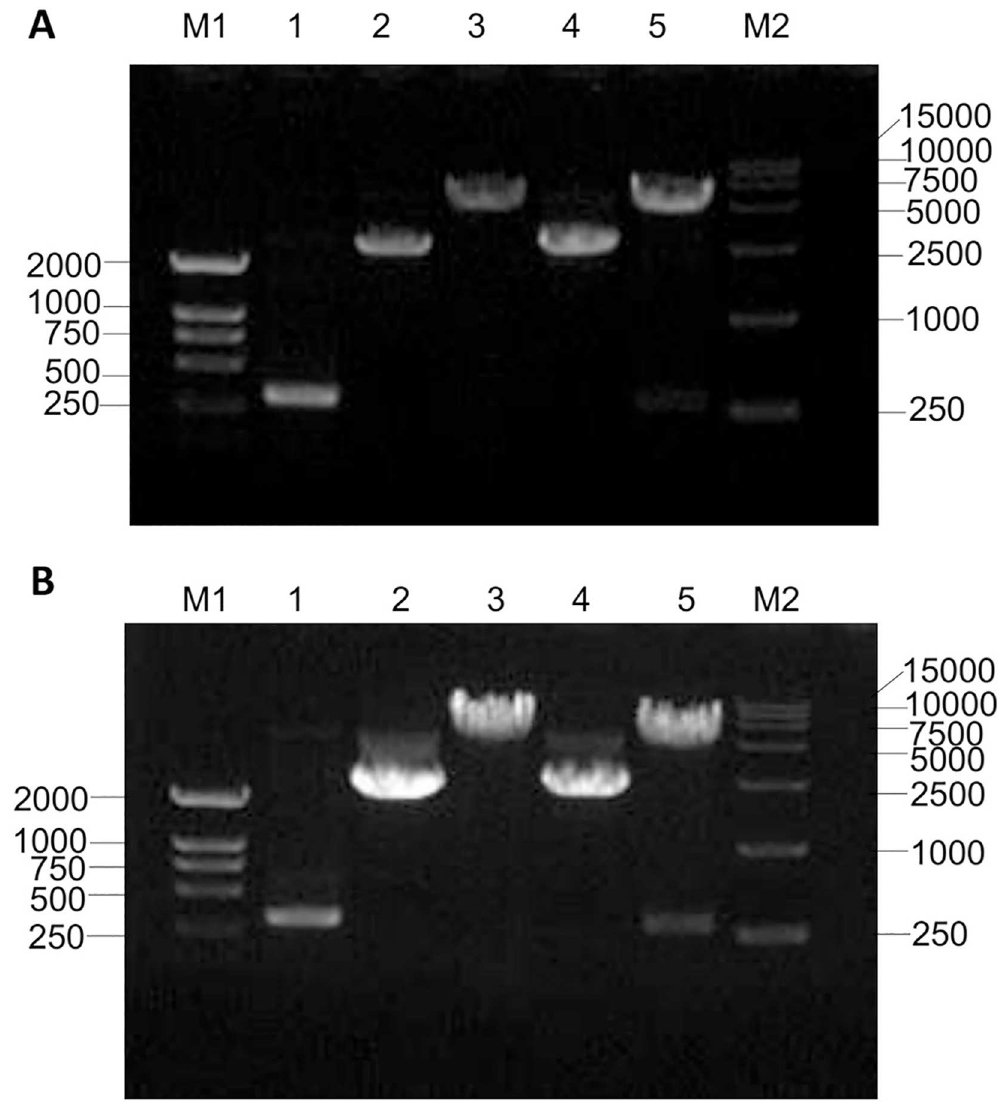
Fig 1. Construction of the expression vector of the HPV58 E7. (A) Constructionof pGEX-4T2-(HPV58-E7) vector. The lane M1 shows the TaKaRa DL2000DNA marker, lane 1 shows the HPV58 E7 gene (PCR from human HPV58-positive cervical epithelialcells); lane 2 is the pGEX-4T2 vector; lane 3 is the cleavedpGEX-4T2 vector by Eco R I and Bam H I; lane 4 shows the reconstructed pGEX-4T2-(HPV58-E7) vector; lane 5 is the verification of pGEX-4T2-(HPV58-E7) vector which was cleavedby Eco R I and Bam H I; the lane M2 is TaKaRa DL 15,000DNA marker. (B) Construction of pEGFP-C1-(HPV58-E7) vector. The lane M1 shows the TaKaRa DL2000DNA marker, lane 1 shows the HPV58 E7 gene (PCR from pGEX-4T2-(HPV-58E7) vector); lane 2 is the pEGFP-C1 vector; lane 3 is the cleavedpEGFP-C1 vector by Eco R I and Bam H I; lane 4 shows the reconstructed pEGFP-C1-(HPV58-E7) vector; lane 5 is the verification of pEGFP-C1-(HPV58-E7) vector which was cleavedby Eco R I and Bam H I; the lane M2 is TaKaRa DL 15,000DNA marker.